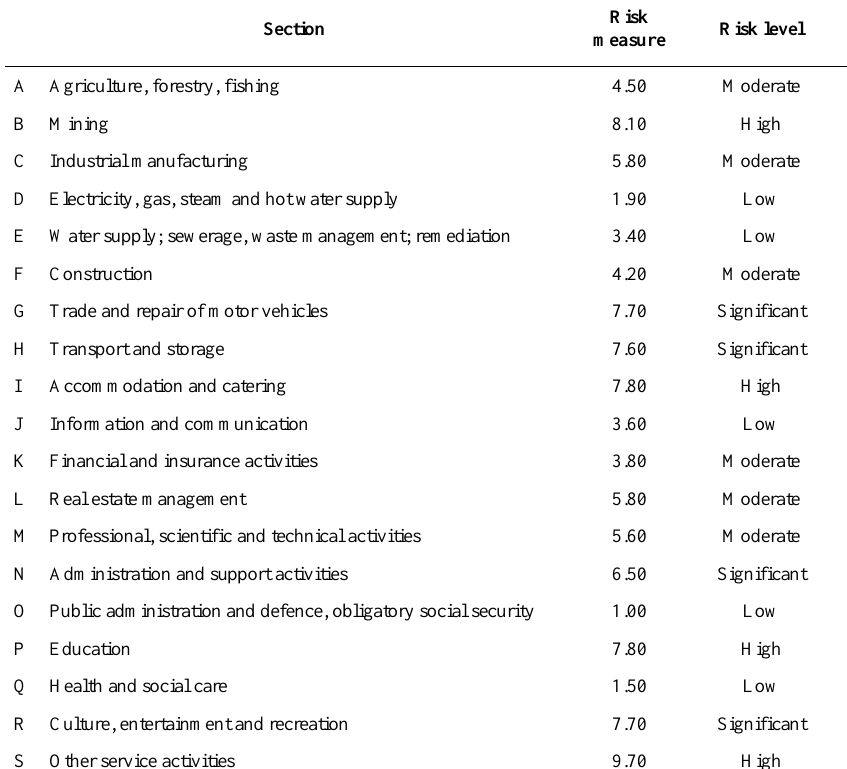
Table 6. Risk measures of individual sections of the Polish economy in the context